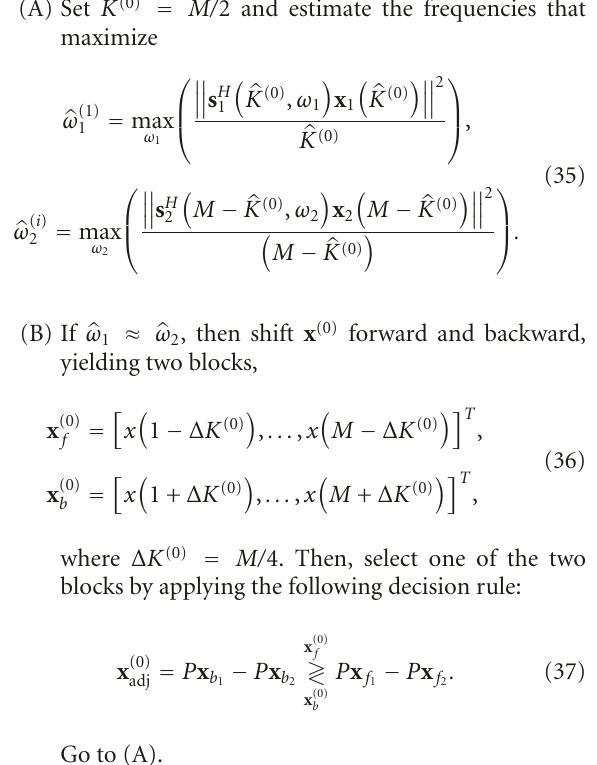
may fall in the range M/ 2 ≤ K ≤ 3 M/ 4.